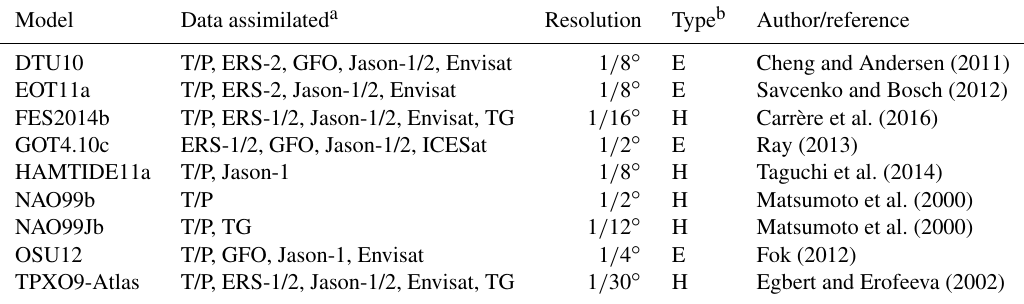
Table 1. Summary of the selected ocean tide models.